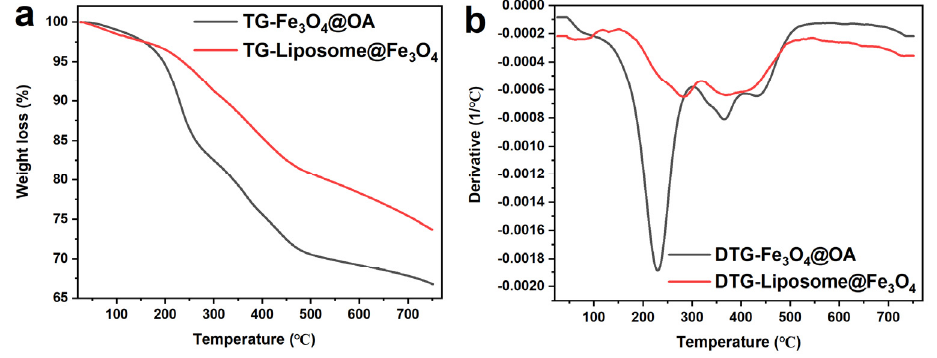
Figure 7. TG ( a ) and DTG ( b ) of Fe 3 O 4 @OA NPs and liposome@Fe 3 O 4.